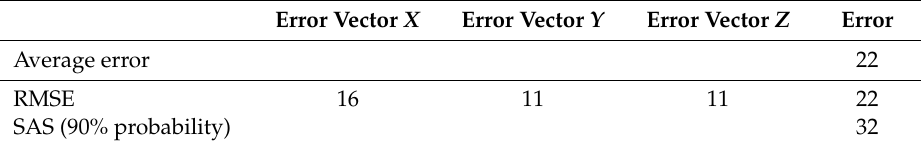
Table 6. First experiment. Results obtained with 17 control points (unit: mm).